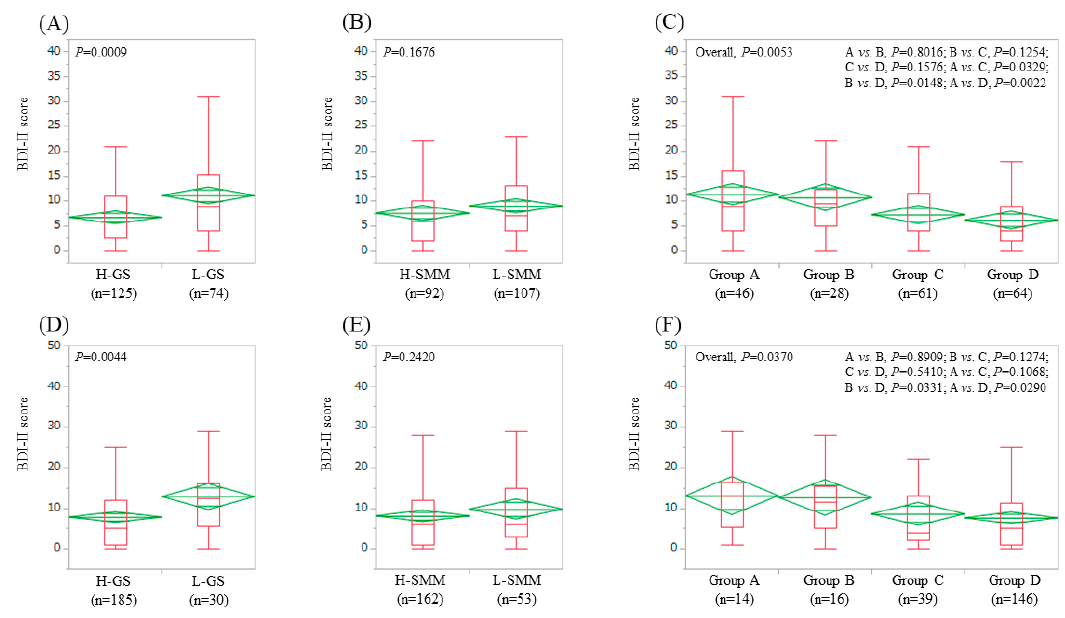
Figure 4. BDI-II score stratified by GS and SMM for patients > 65 years ( n = 199). ( A ) Lower GS (L-GS) vs. Higher GS (H-GS). ( B ) Lower SMM (L-SMM) vs. Higher SMM (H-SMM). ( C ) Comparison among four types (group A, B, C and D). BDI-II score stratified by GS and SMM for patients < 65 years ( n = 215). ( D ) L-GS vs. H-GS. ( E ) L-SMM vs. H-SMM. ( F ) Comparison among four groups (group A, B, C and D). Group A indicates L-GS and L-SMM. Group B indicates L-GS and H-SMM. Group C indicates H-GS and L-SMM. Group D indicates H-GS and